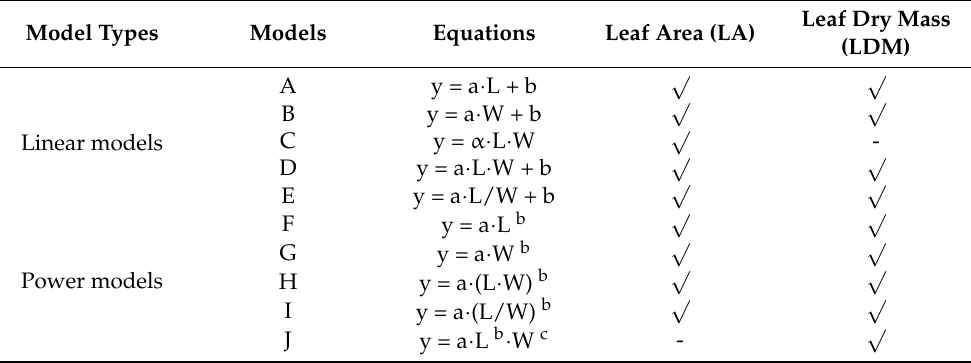
Table 2. Models for LA and LDM estimations. The models used by previous studies and other possible models on the basis of L and W were employed in this study